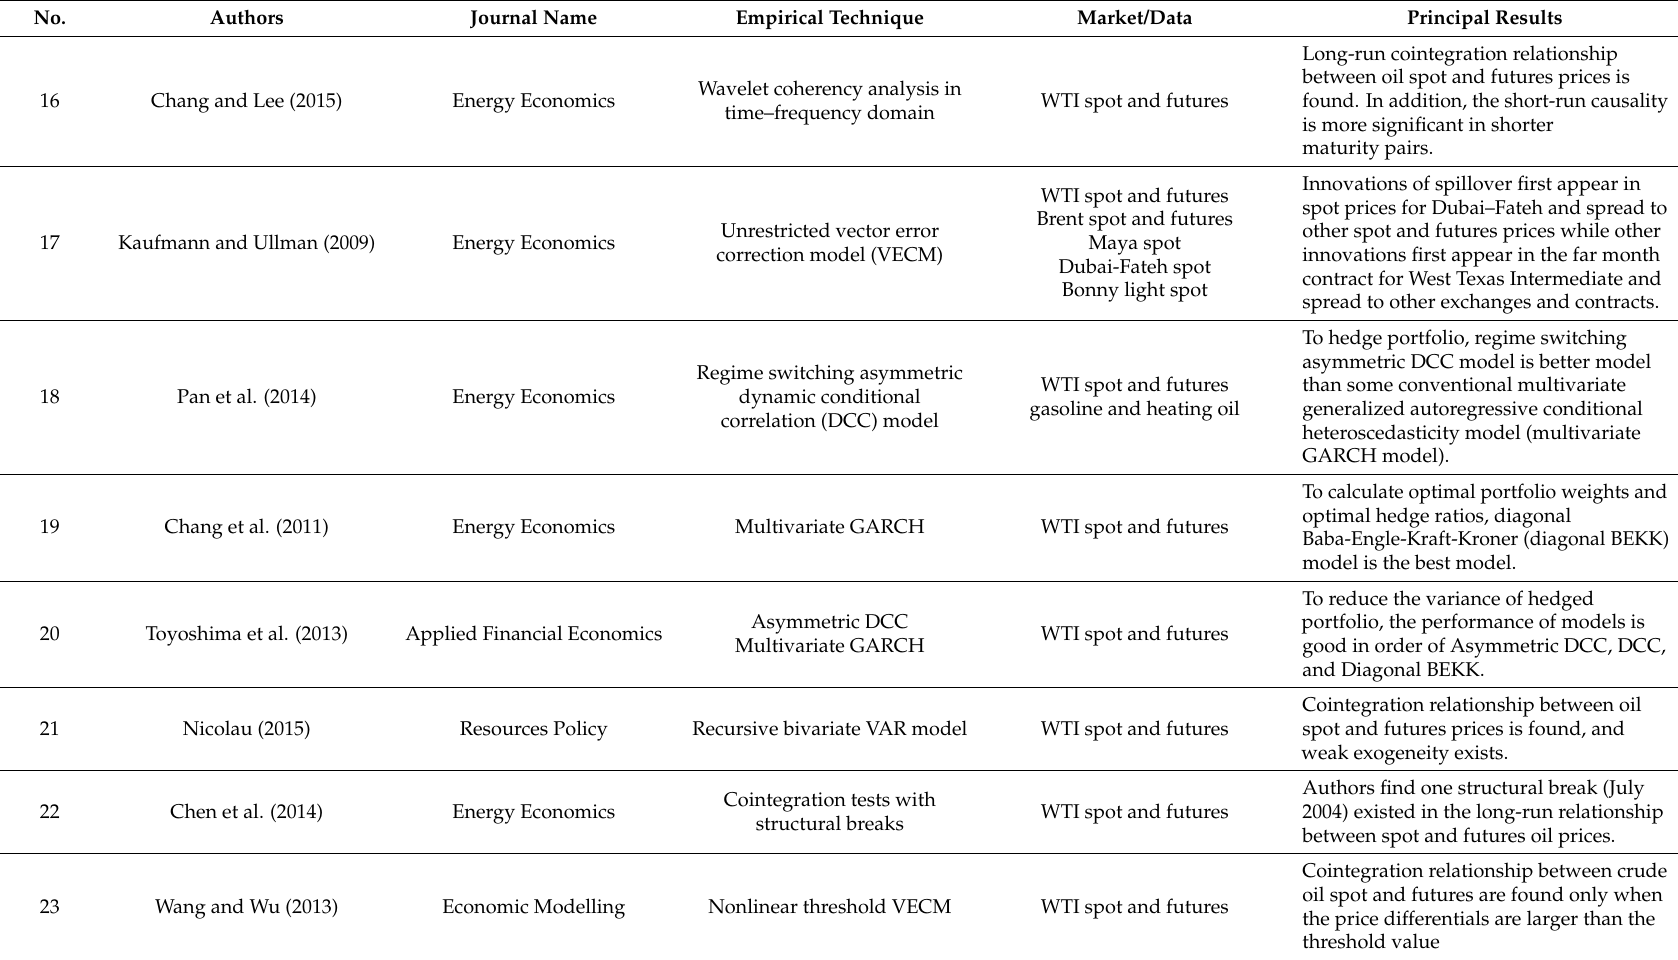
Table 1. Previous studies and their main